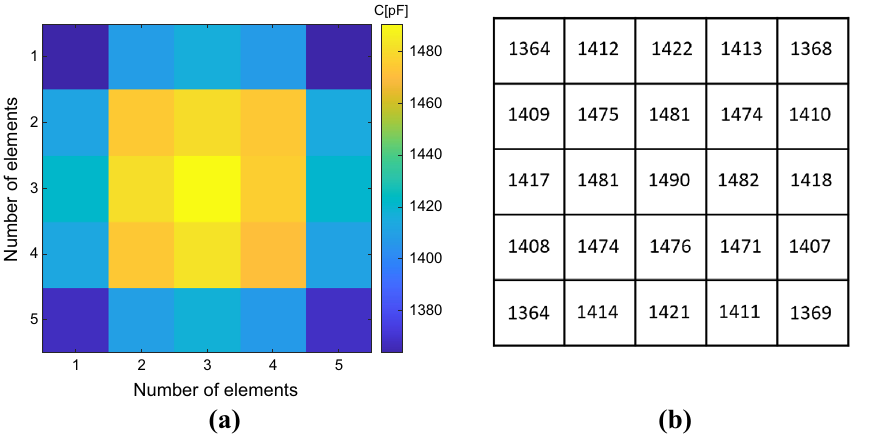
Figure 9. ( a ) Capacitance map required to homogenize the PCB metasurface response calculated through the analytical model previously exposed. ( b ) Capacitance numerical values (pF) used to homogenize the PCB metasurface.